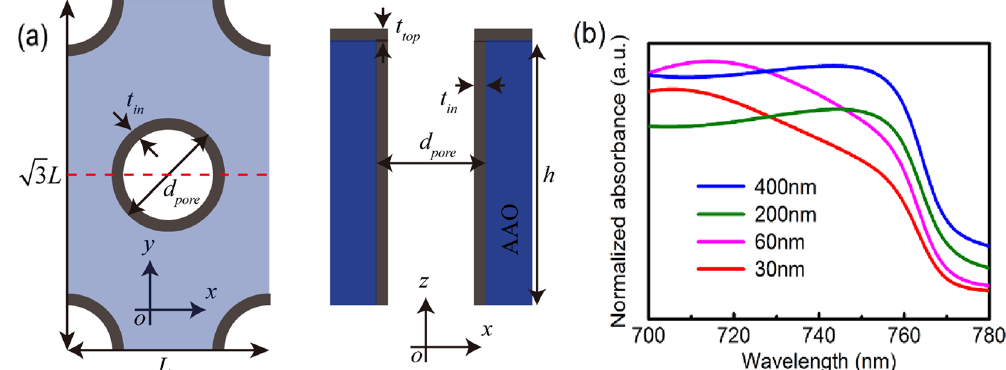
Figure 4. ( a ) Schematic diagram of finite element modeling. The dark, wathet blue and dark blue regions represent CH 3 NH 3 PbI 3 on the top surface, inwall and AAO template itself, respectively; ( b ) Simulated absorbance in the range of 700~800